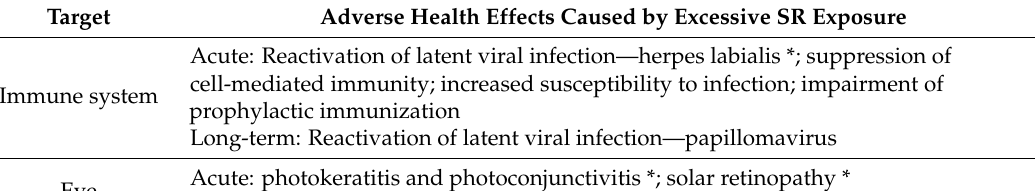
Table 3. Adverse health effects of solar radiation exposure in humans (WHO 2006, adapted) [38].